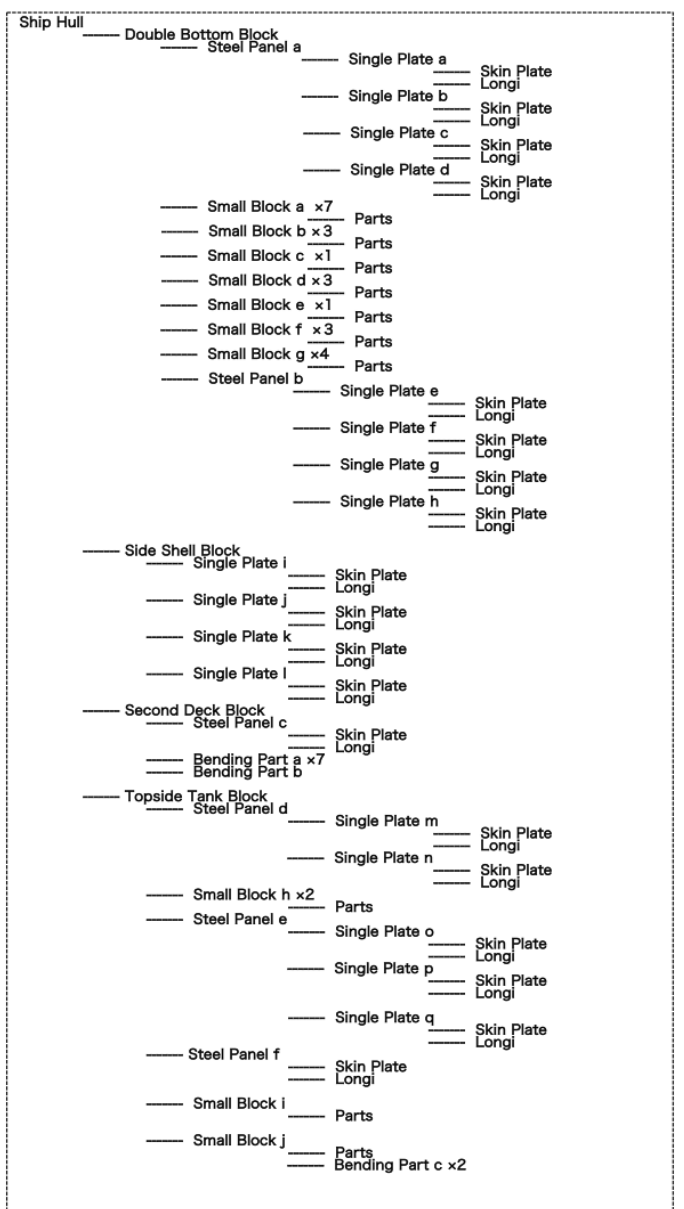
Figure 10. M-BOM Data in Case